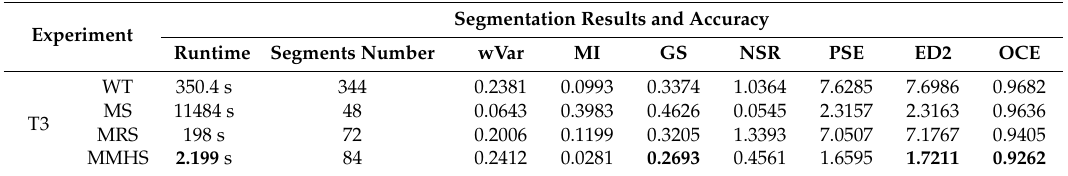
Table 7. The quantitative assessment results of the Montgomery aerial image (T3). Experiment